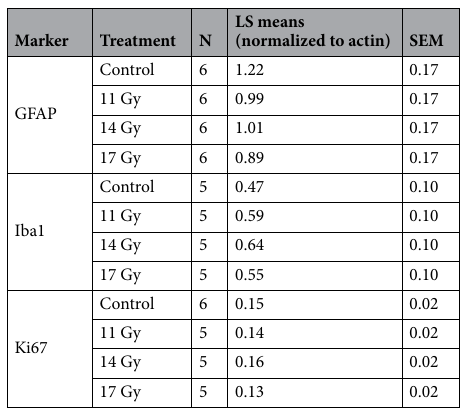
Table 1. Striatal markers.